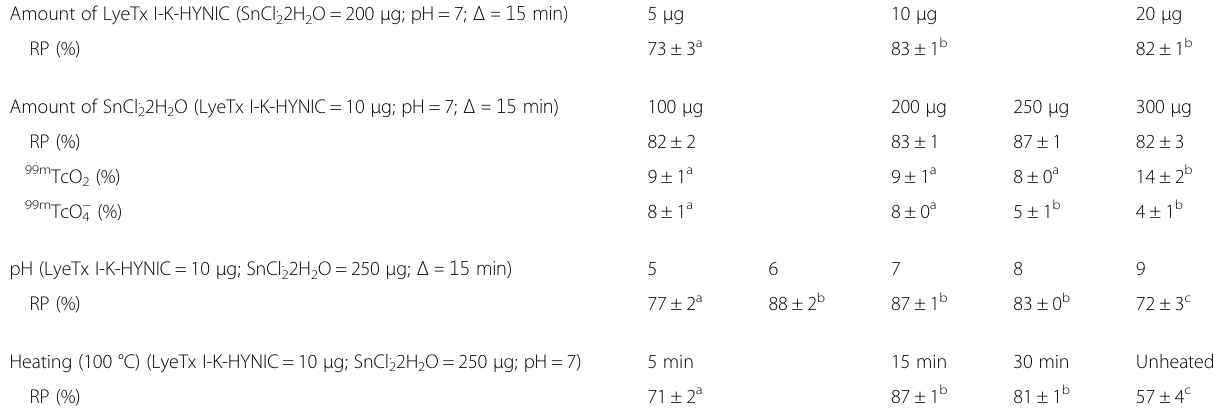
Table 3 Radiolabeling standardization of the synthetic peptide LyeTx I-K-HYNIC derivative with 99m Tc Amount of LyeTx I-K-HYNIC (SnCl 2. 2H 2 O = 200 μ g; pH = 7; Δ = 15